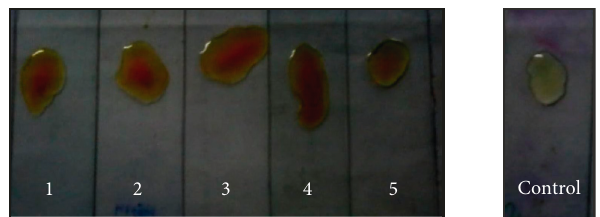
wide encompassing states.